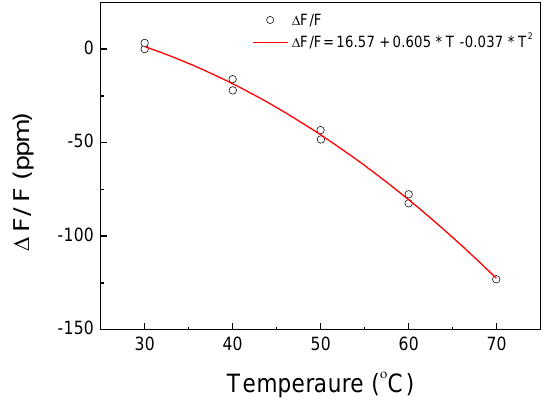
Figure 5. Variation of the SAW resonance frequency as a function of temperature (25 °C).